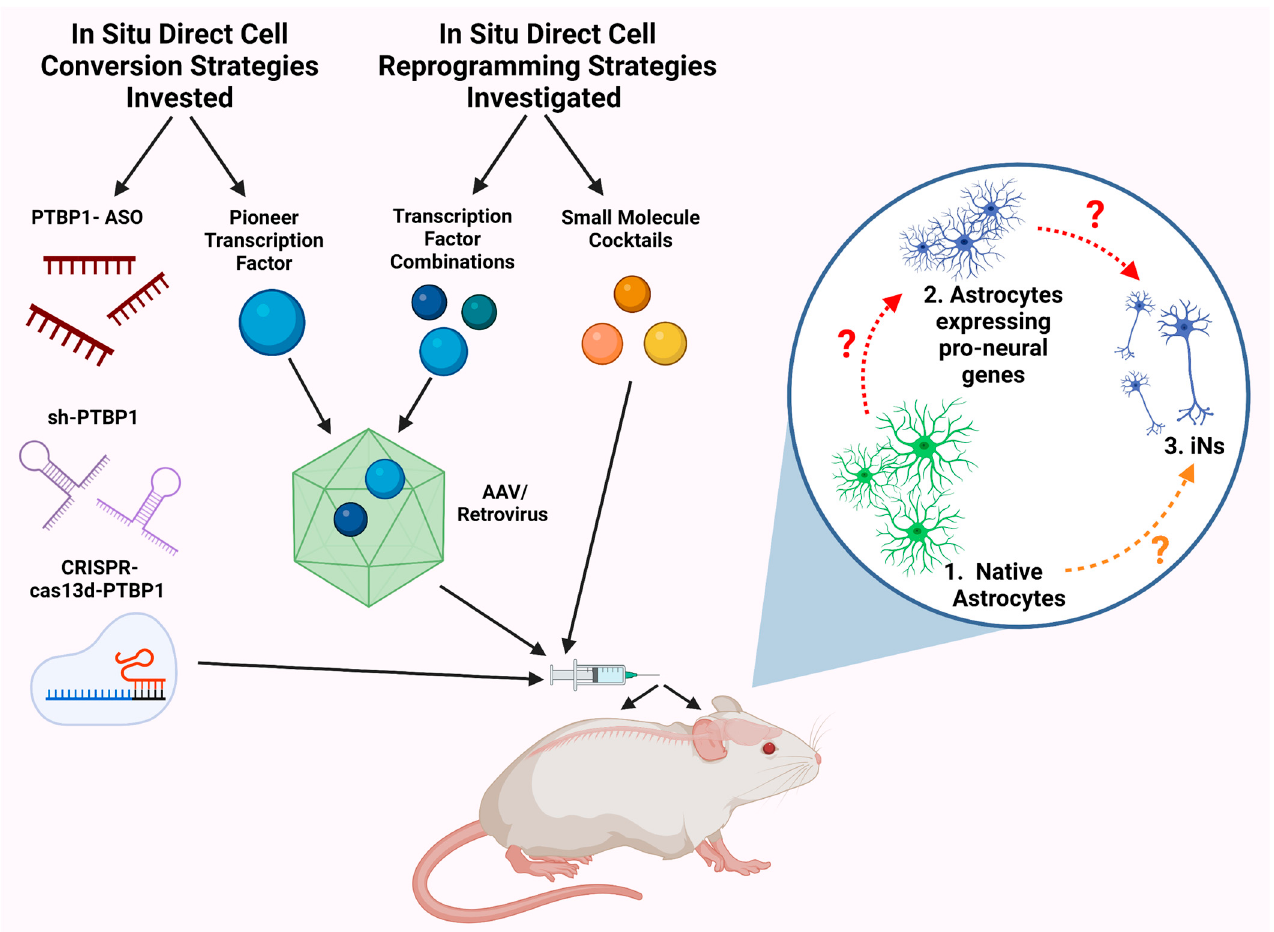
Figure 2. Schematic illustration of the general principles used to guide cell conversion or reprogram- ming for attaining neurons from astrocytes in adult animals. Common AtN conversion strategies were based on the manipulation of a single lineage-specific transcription factor (TF) to alter astrocytic chromatin accessibility and drive neuronal gene expression patterns in astrocytes. This was experimentally operated via two mechanisms: (1) the ectopic expression of a pioneer factor pack- aged into a viral vector; (2) the genetic knockdown of polypyrimidine tract binding protein 1 (PTBP1) using short-hairpin RNAs (shRNA), antisense oligonucleotides (ASO), or CRISPR-cas13d. Conversely, direct AtN reprogramming strategies utilize 3 or more TFs, small molecules, or signal- ing pathway modulators affecting multiple epigenetic and genetic elements of the starting astro- cytes. For in vivo studies, both approaches relied on microinjection of the AtN induction fac- tors/molecules into the target brain or spinal cord region. While the data and biological underpin- nings of all AtN tactics remain to be fully validated/elucidated (indicated by question marks), it was suggested that direct conversion protocols induced a direct transition from one somatic cell type into another without passing through a multipotent or pluripotent state (orange dashed arrow) and direct reprogramming procedures were thought to return the starting cell to a more plastic and potentially multipotent-like state before triggering differentiation into the neuron-like phenotype (red dashed arrow; all images created using BioRender.com, accessed on: 17 November 2022).